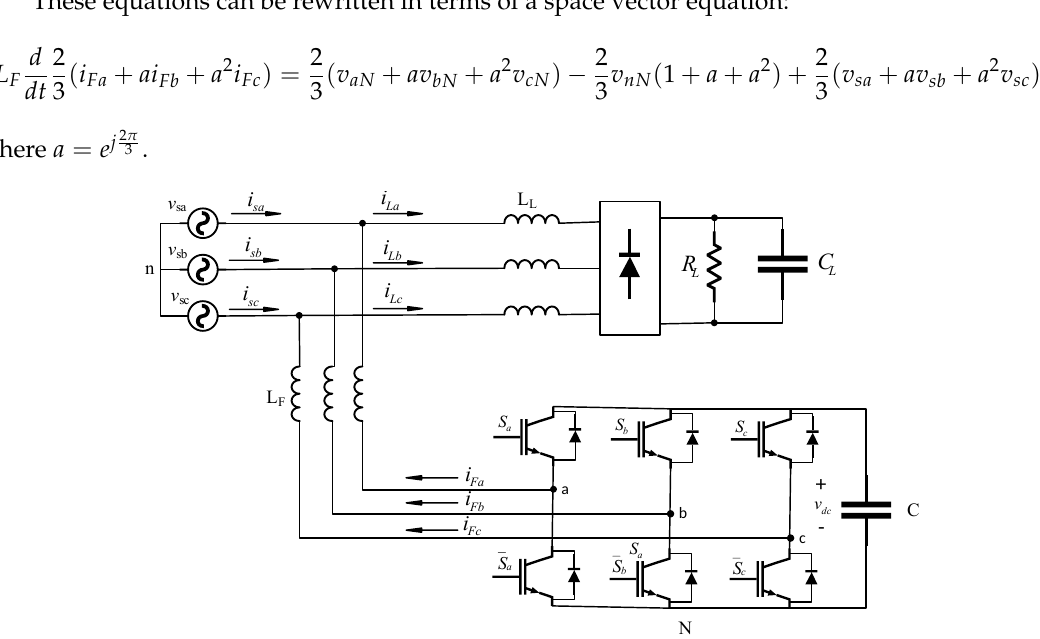
Figure 1. Three-phase shunt active power